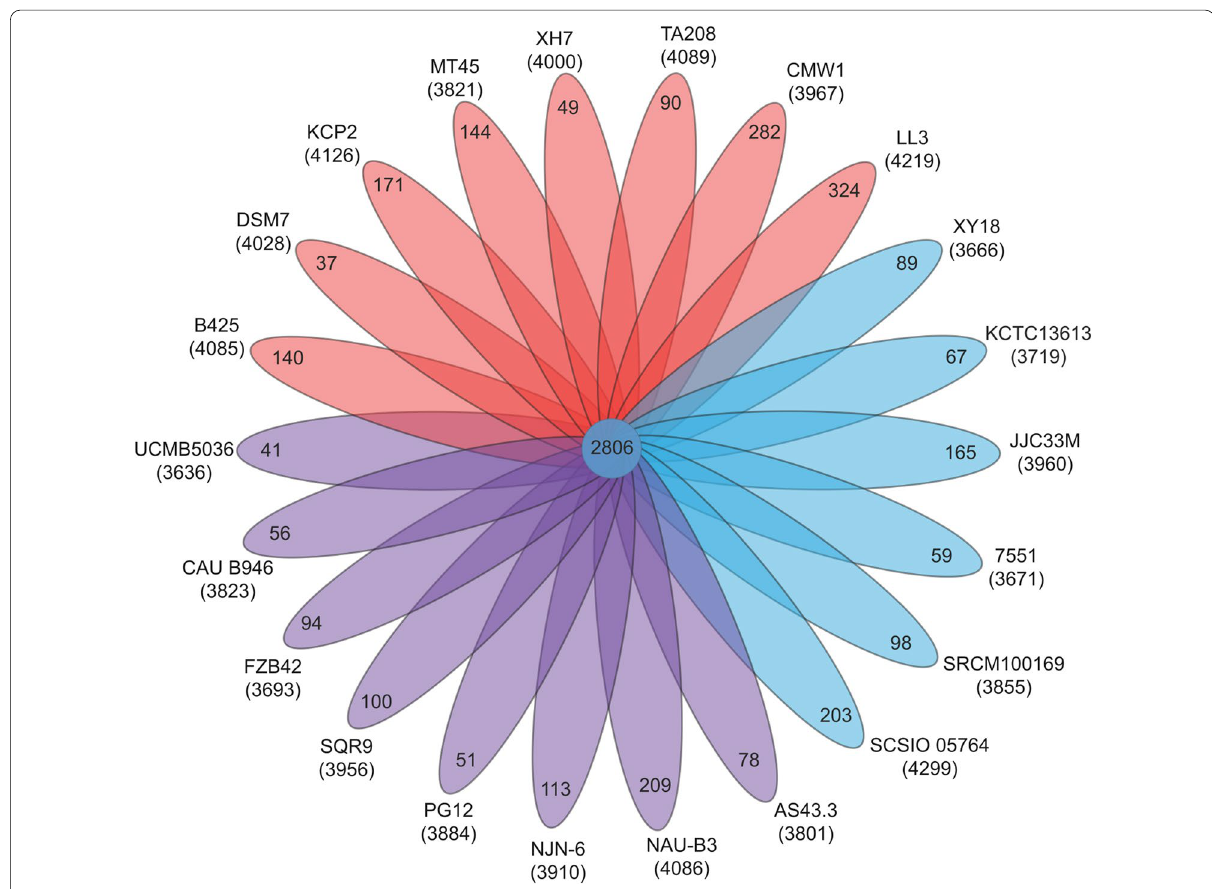
Fig. 3 Genomic diversity of the B. amyloliquefaciens group strains. Each strain is represented by a colored oval: B. velezensis (purple), B. amyloliquefaciens (red) and B. siamensis (blue). The number of orthologous coding sequences (CDS) shared by all strains (the core genome) is in the center. Overlapping regions show the number of CDSs conserved only within the specified genomes. Numbers in non-overlapping portions of each oval indicate the number of CDSs unique to each strain. The total number of protein-coding genes within each genome is listed below